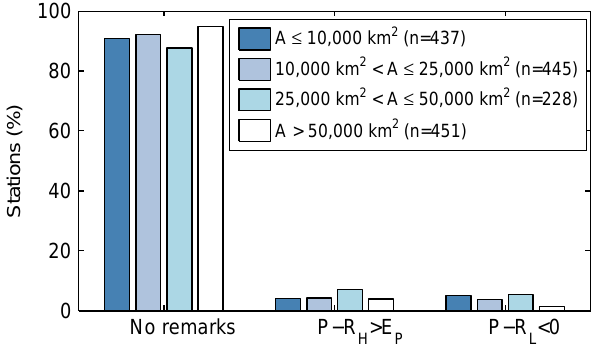
Fig. 10. Basins with and without data inconsistencies, based on CRU precipitation and potential evaporation, in different area